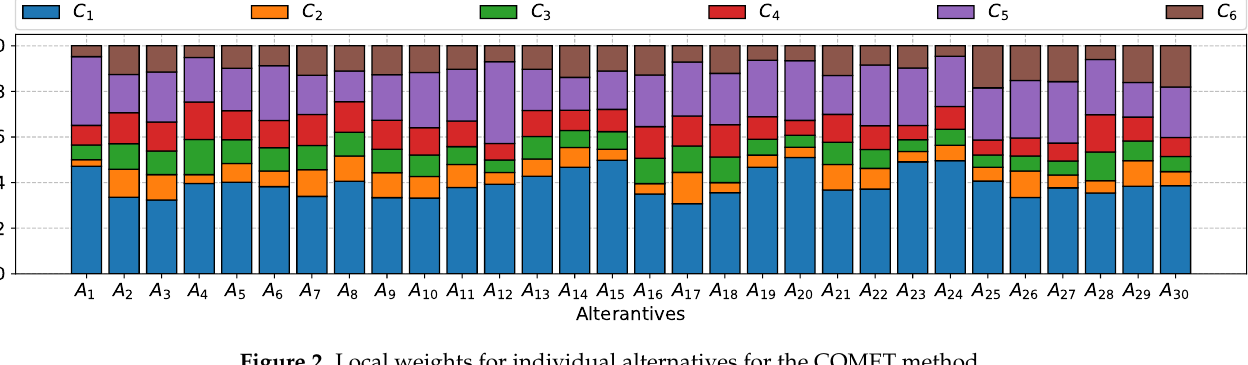
Figure 2. Local weights for individual alternatives for the COMET method.